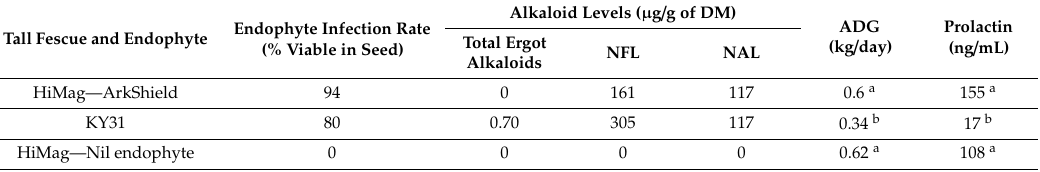
Table 10. Mean concentrations ( µ g / g of DM) in the herbage of measured ergot alkaloids and loline levels (N-formyl loline (NFL) and N-acetyl loline (NAL)), average daily weight gain (ADG) of 2 year old steers, and blood serum prolactin levels across two sites in the USA. (Taken from [465]). Alkaloid Levels ( µ g / g of DM) ADG Prolactin TallFescue andEndophyte Endophyte Infection Rate (kg / day) (ng / mL)Total Ergot (% Viable in Seed) NFL NAL Alkaloids HiMag—ArkShield 94 0 161 117 0.6 a 155 a KY31 80 0.70 305 117 0.34 b 17 b HiMag—Nil endophyte 0 0 0 0 0.62